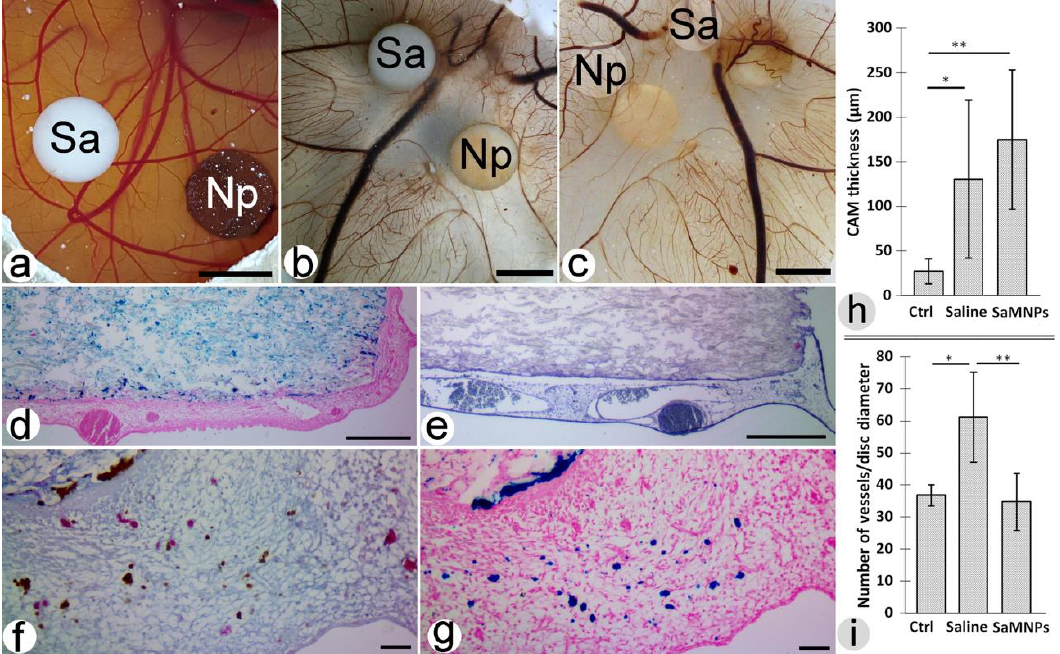
Figure 1. The morphological effects of SaMNPs on the CAM assay. ( a ) Discs where implantation occurred were pre-soaked with saline (Sa) and SaMNPs (Np) on a seven-day-old CAM; ( b , c ) Formalin fixed discs with surrounding a CAM (top and bottom view); ( d , f , g ) Histological sections through the Np-disc; ( e ) histological section through the Sa-disc; thickness ( h ) and counted vessels ( i ) variations on the normal CAM (Ctrl), Np-disc, and Sa-disc underneath the CAM (* p < 0.05; ** p < 0.001). Hematoxylin & eosin ( e ), Perl’s Prussian blue ( d , g ) and Trichrome azan ( f ) staining; Bar = 5 mm ( a–c ); 100 µm ( d , e ); 10 µm ( f , g ).